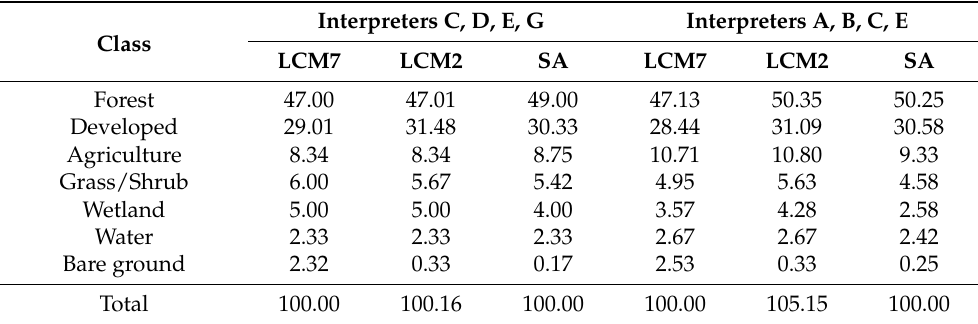
Table 8. Evaluation of additivity of percent area estimates (2010 land cover and two example cases of four interpreters) for LCM using two (LCM2) or seven (LCM7) classes as the manifest variables and SA (additivity defined as the percent area of all land cover classes summing to